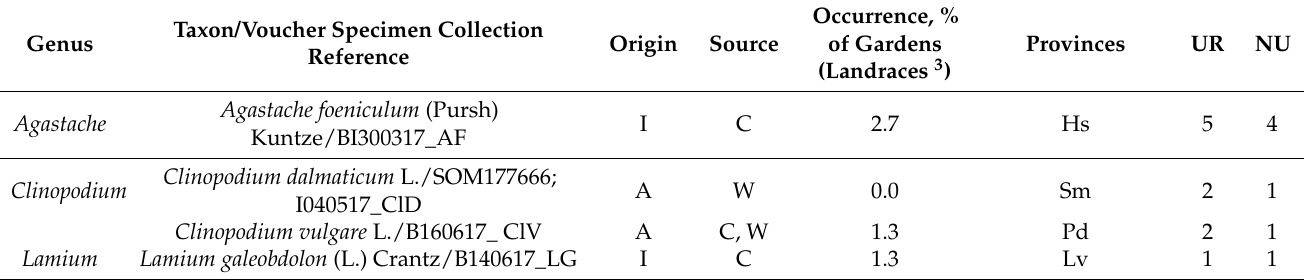
Table 2. Cultivated and wild Lamiaceae taxa used in rural